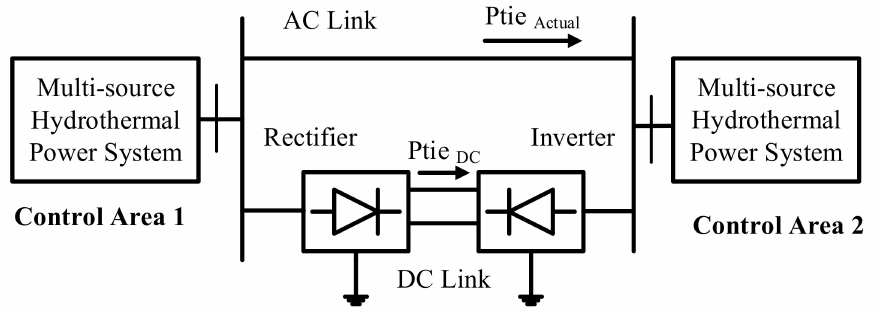
Figure 4. Two Area multi-source power system interconnected via AC/DC parallel line